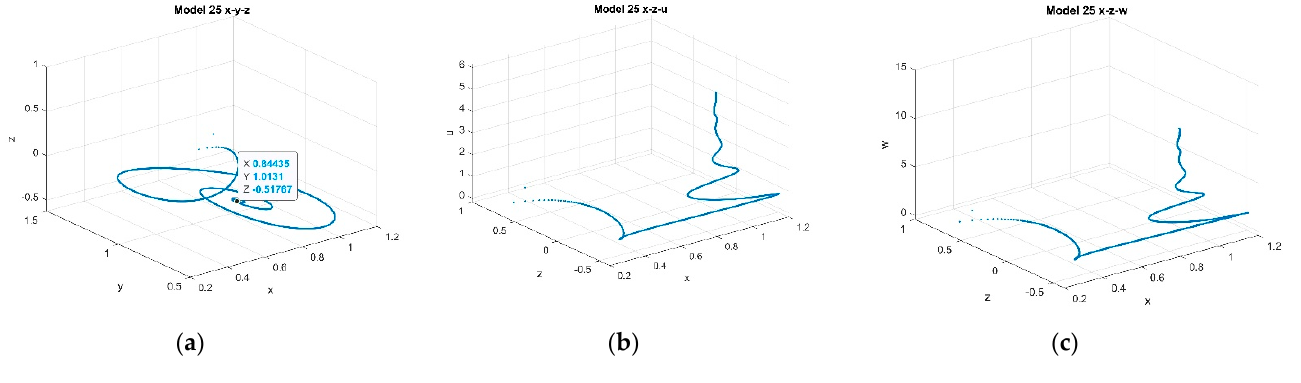
Figure 16. Phase portraits ( a ) x − y − z , ( b ) x − u − z , ( c ) x − z − w , at h = 0.002, k = 2, p = 1.94, α 5 = 0.3 for models (22) through (25).